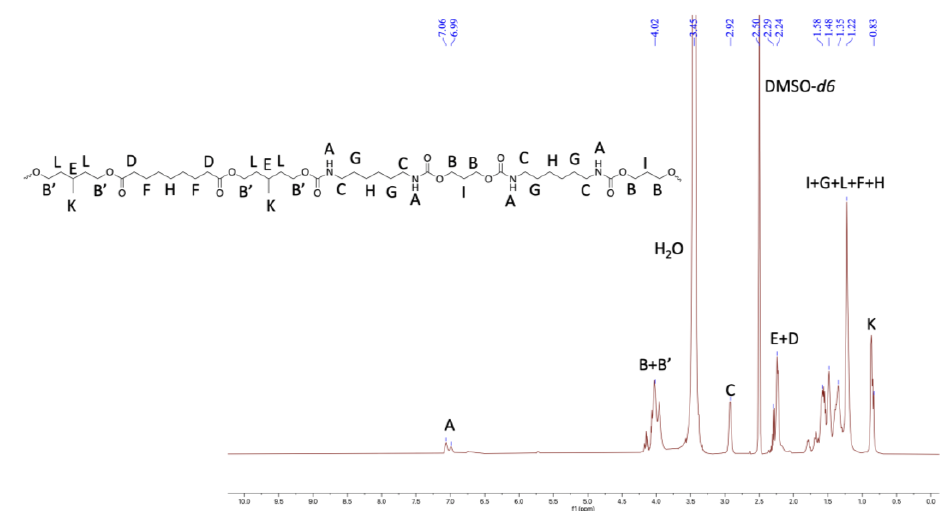
Figure 4. 1 HNMR of TPU2 in DMSO- d6 (500 MHz, 298 K).